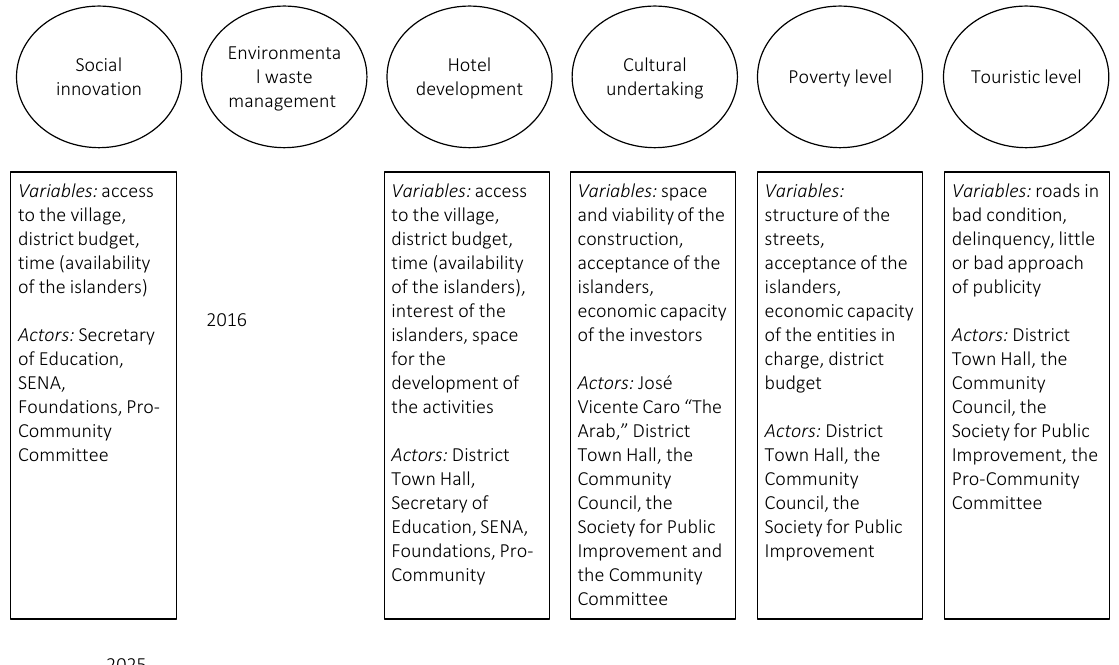
Figure 4. Desired scenario: 1 1 1 1 1 1. Probability of Occurrence of 11.30%>> The dreamed